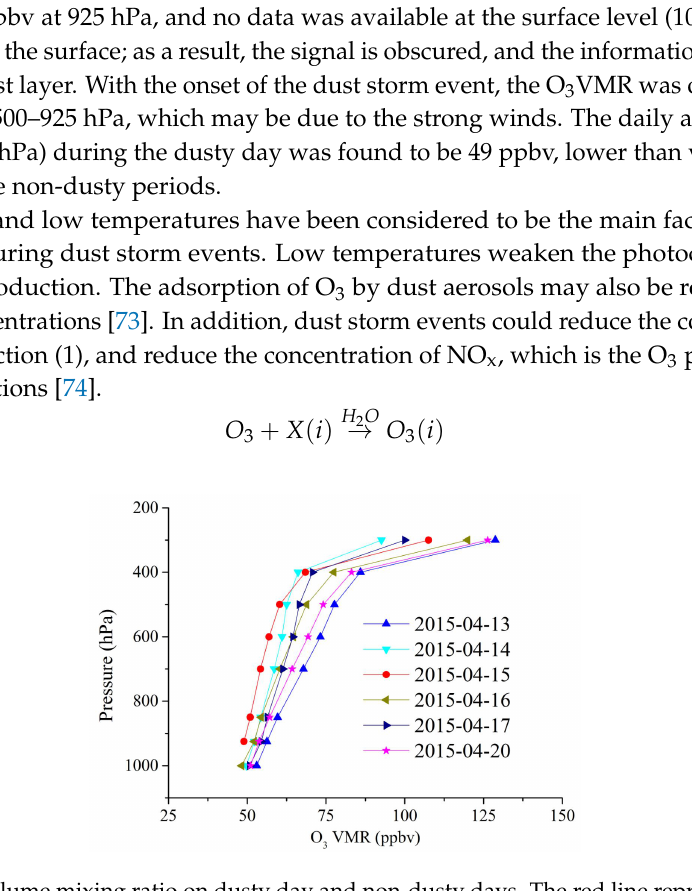
Figure 11. O 3 volume mixing ratio on dusty day and non-dusty days. The red line represents vertical profile on dusty